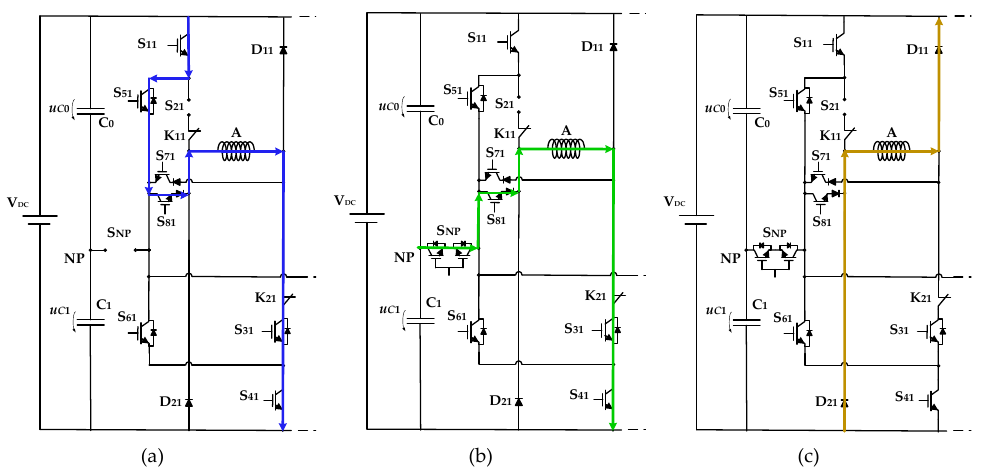
Figure 3. Fault-tolerant solution based on the NPC-AHB topology applied to an 8/6 SRM . Example of an open-circuit fault in power device S 21 and recover path to obtain the full ( a ), middle ( b ) voltage of phase A and ( c ) demagnetization process.